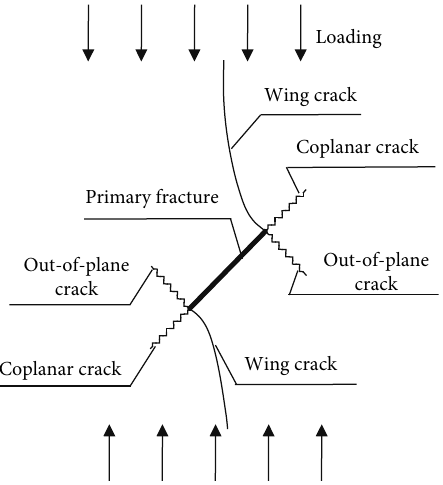
Figure 2: The secondary crack